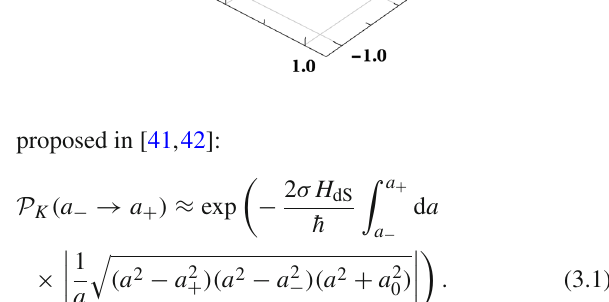
Fig. 2 The evolution of the squared scale factor as a function of the conformal Lorentzian time η and conformal Euclidean time ˜ η . In order to be able to plot the evolution of the scale factor in a single figure including the Lorentzian and Euclidean solutions, we have rescaled the conformal time as follows: for the baby universe (red) (cid:12)η = (η − η − )/ | η ( − η − | a = 0 ) with (cid:12)η ∈ [− 1 , 0 ] ; for